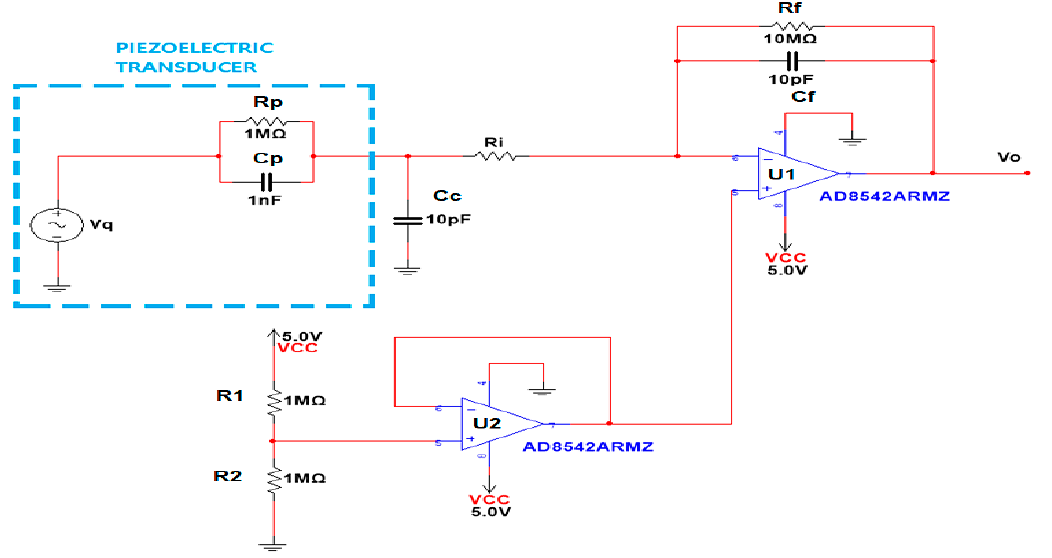
Figure 24. Schematic of the designed charge amplifier. The piezoelectric transducer is represented with its Thevenin equivalent